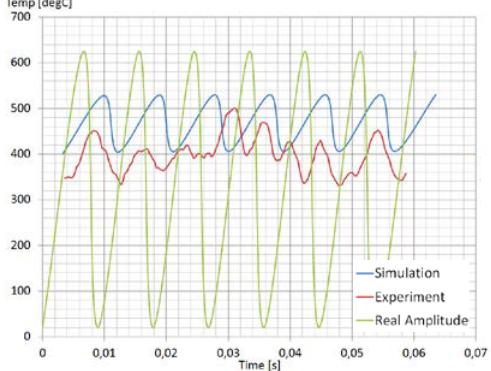
Fig. 12. Comparison of simulated and real sensor behavior with estimated real temperature course